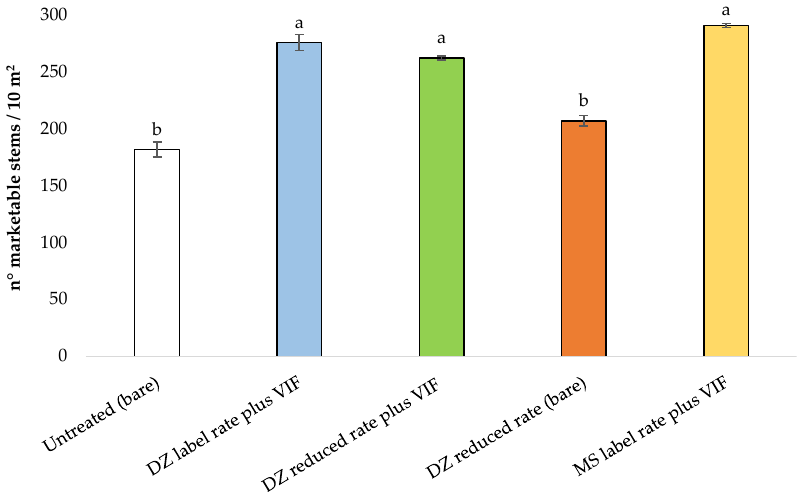
Figure 3. Performances of fumigation treatments in enhancing yield (commercial stalks of Chrysanthemum × morifolium cv Anastasia) detected in treated plots compared with control plot (white column). Data (from two combined trials) are means of four replicates (plots). Bars followed by the same letters are not significantly different among them according to Fisher’s least significance difference test (α = 0.05).